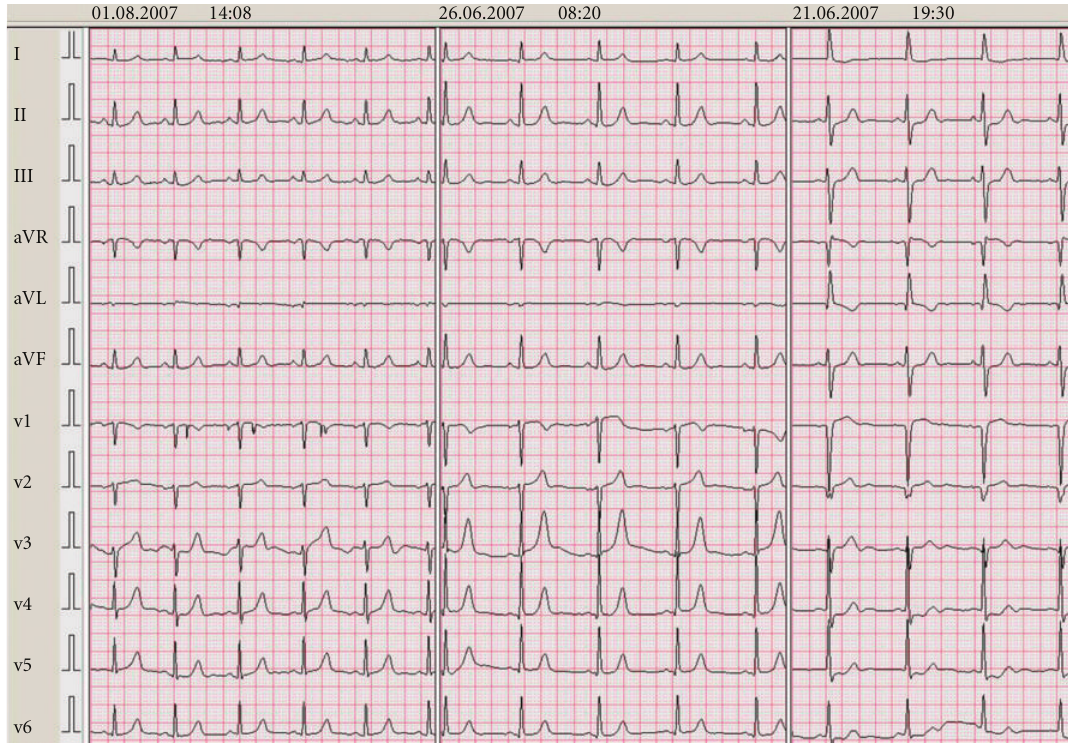
Figure 3: Case 2 (EKGs shown chronologically from right to left).